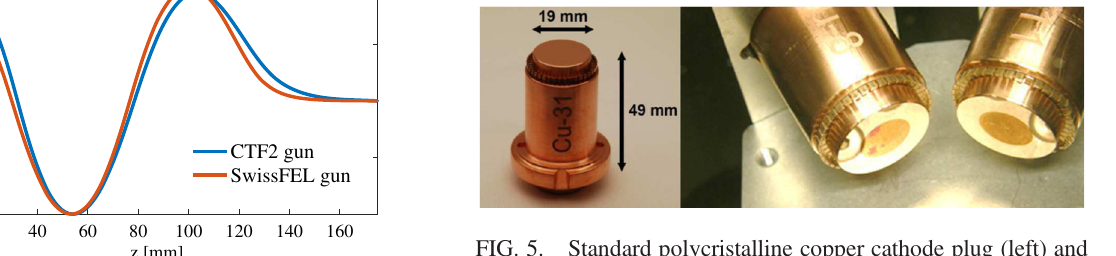
FIG. 5. Standard polycristalline copper cathode plug (left) and cathodes (right) where a disc of 10 mm diameter of Cs 2 Te has been deposited on the front surface. Both types were used at